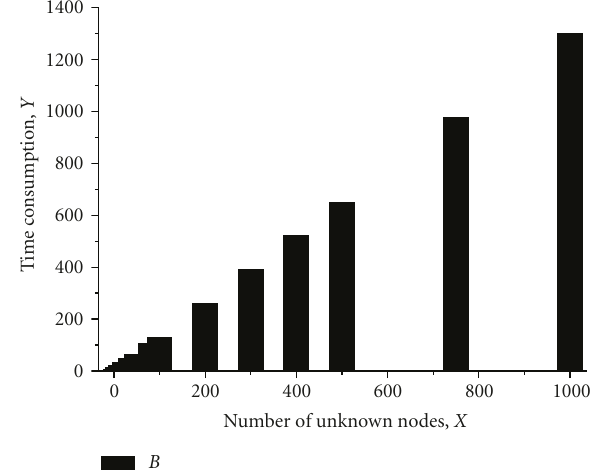
ffi c in Kcdlocation process.